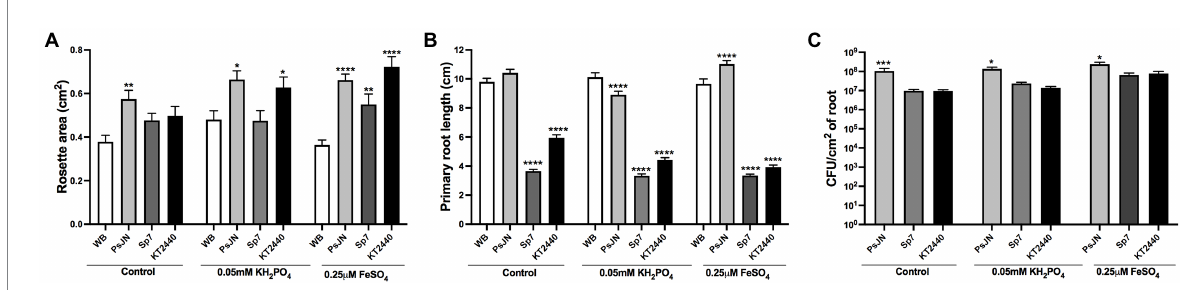
FIGURE 1 Effects of different phosphate and iron concentrations in plant growth in Arabidopsis thaliana inoculated with beneficial rhizobacteria. Rosette area (A) , primary root length (B) , and root colonization (C) in plants 15 days after sowing in control medium (1 mM KH 2 PO 4 /100 μ M FeSO 4 ), low-P (0.05 mM KH 2 PO 4 /100 μ M FeSO 4 ), or low-Fe (1 mM KH 2 PO 4 /0.25 μ M FeSO 4 ). Non-inoculated plants are noted as WB, and inoculations with Paraburkholderia phytofirmans PsJN, Azospirillum brasilense Sp7, or Pseudomonas putida KT2440 are noted as PsJN, Sp7, and KT2440, respectively. Data are means ± SE of 18 replicates per treatment. Asterisks indicate significant differences between each treatment and the control group according to a Two-way ANOVA with multiple comparisons test (* p < 0.05; ** p < 0.01; *** p < 0.001; and **** p <